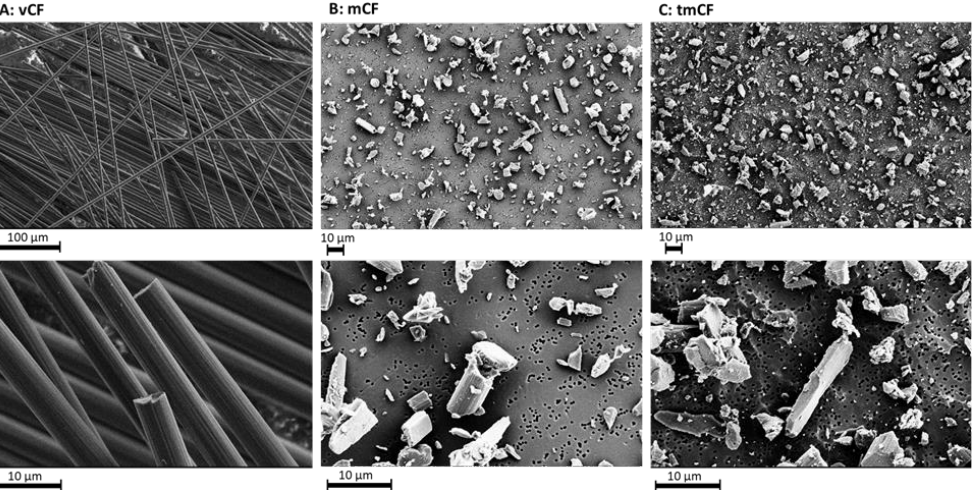
Figure 1. SEM images of the PAN-based CF: ( A ): the original CF as delivered by the manufacturer. Magnification: X200 (top panel), X2000 (lower panel). ( B ): Fiber fragments of mCF deposited on the membrane surface in the air – liquid interface exposure chamber. Magnification: ×500 (top panel), ×2000 (lower panel). ( C ): Fiber fragments of tmCF deposited on the membrane surface in the air – liquid interface exposure chamber. Magnification: ×500 (top panel), ×2000 (lower panel). Images were taken with a Zeiss Supra 55 VP (Zeiss GmbH, Jena, Germany).